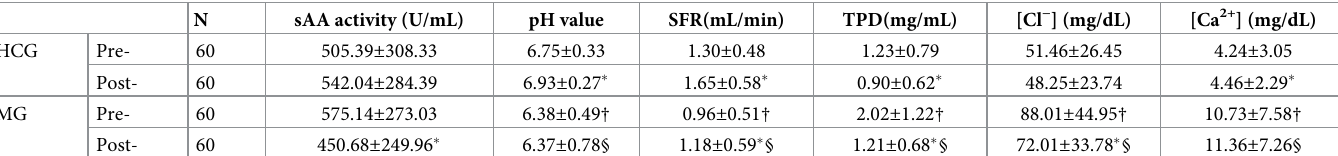
Table 2. Salivary biochemical characteristics under pre- and post-acid stimulation